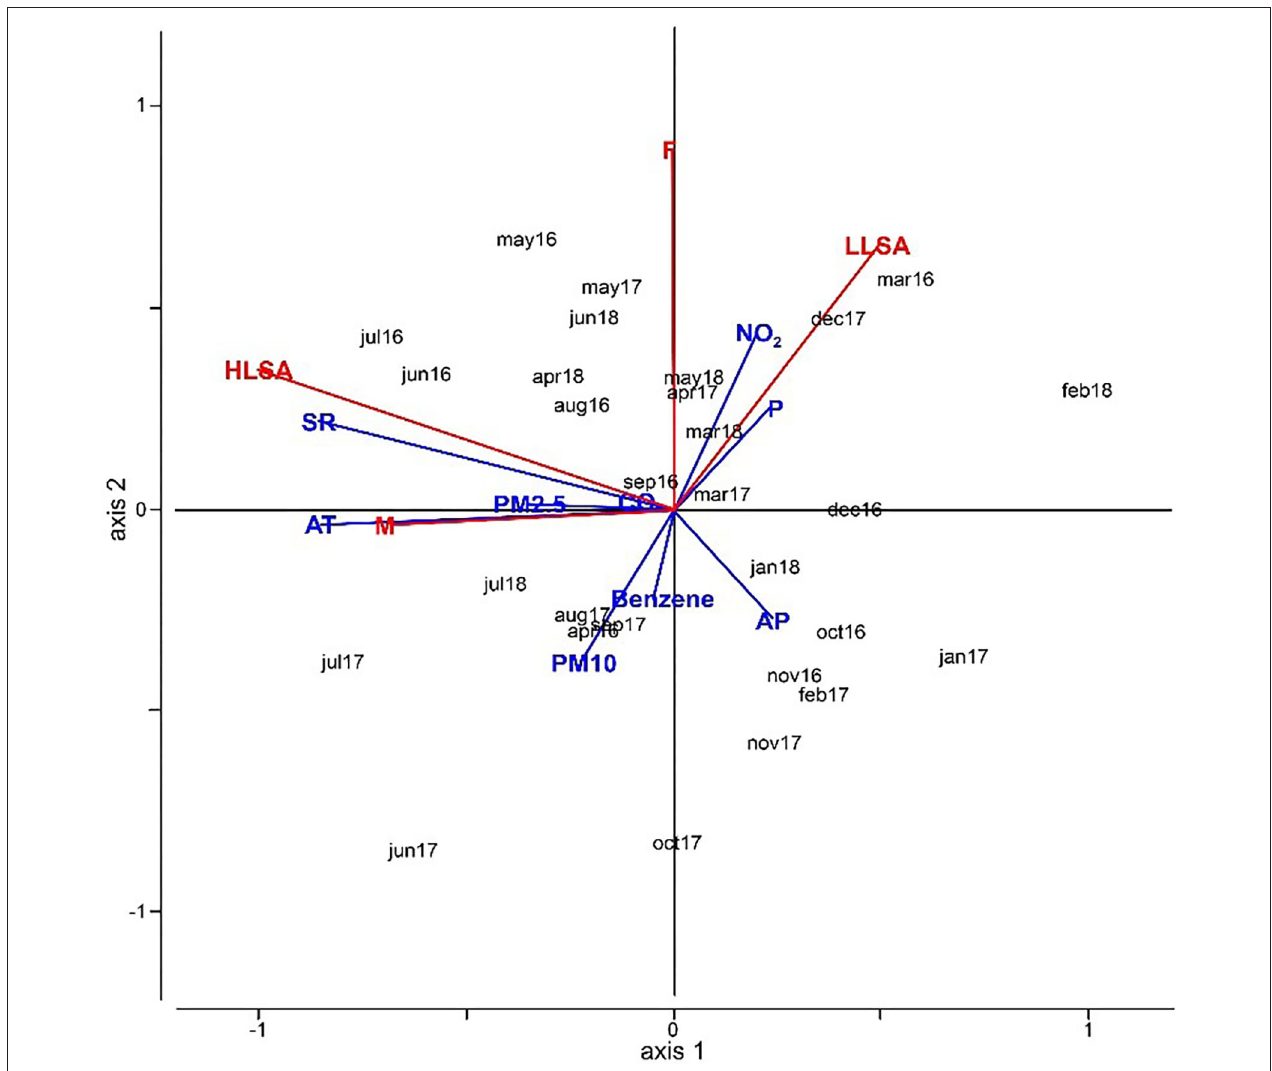
FIGURE 2 | RDA analysis combining suicide lethality and gender (response variables) with environmental parameters. The sum of all canonical eigenvalues is